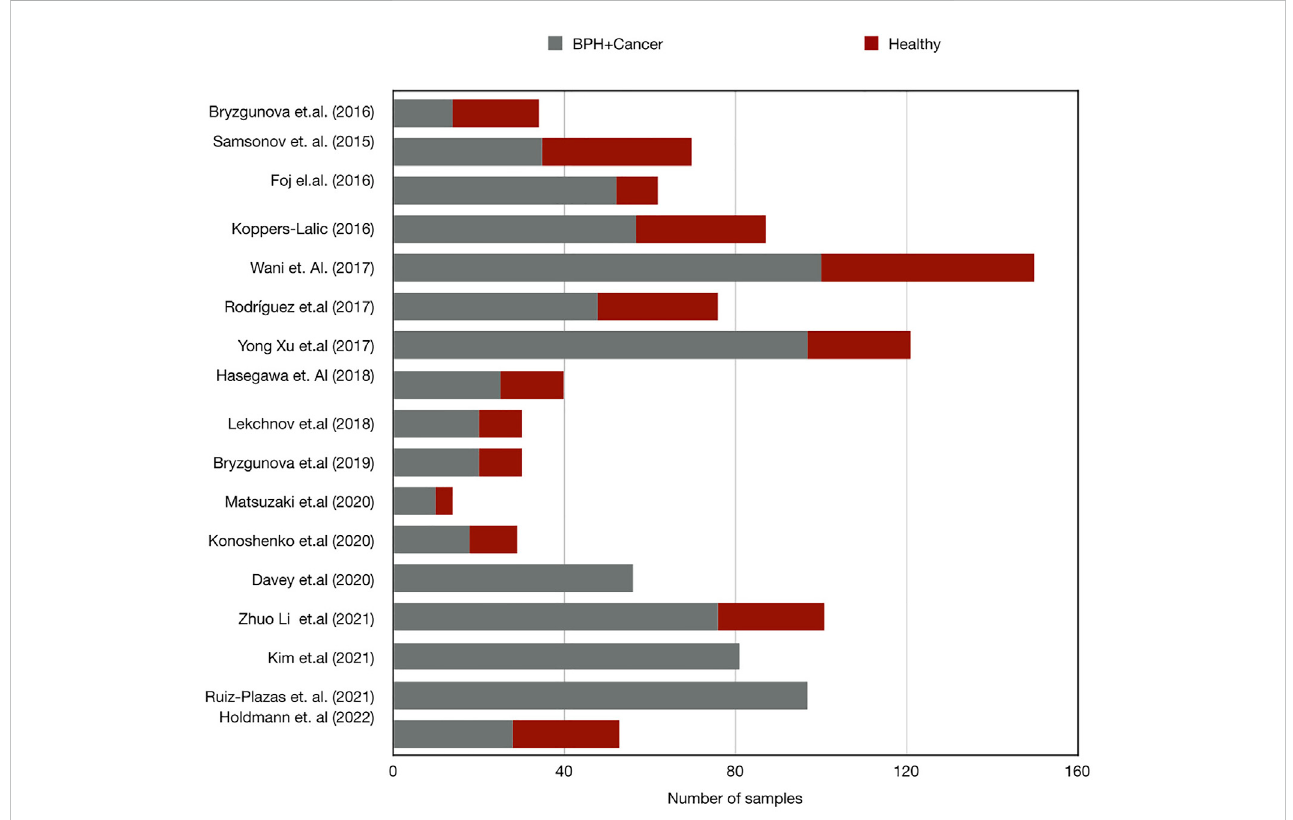
Barchartdemonstratingthenumberofsamplesincaseandcontrolgroupsets inmiRNAresearchinPCa.Control,healthysubject;BPH,Benignprostate hyperplasia; Cancer, prostate